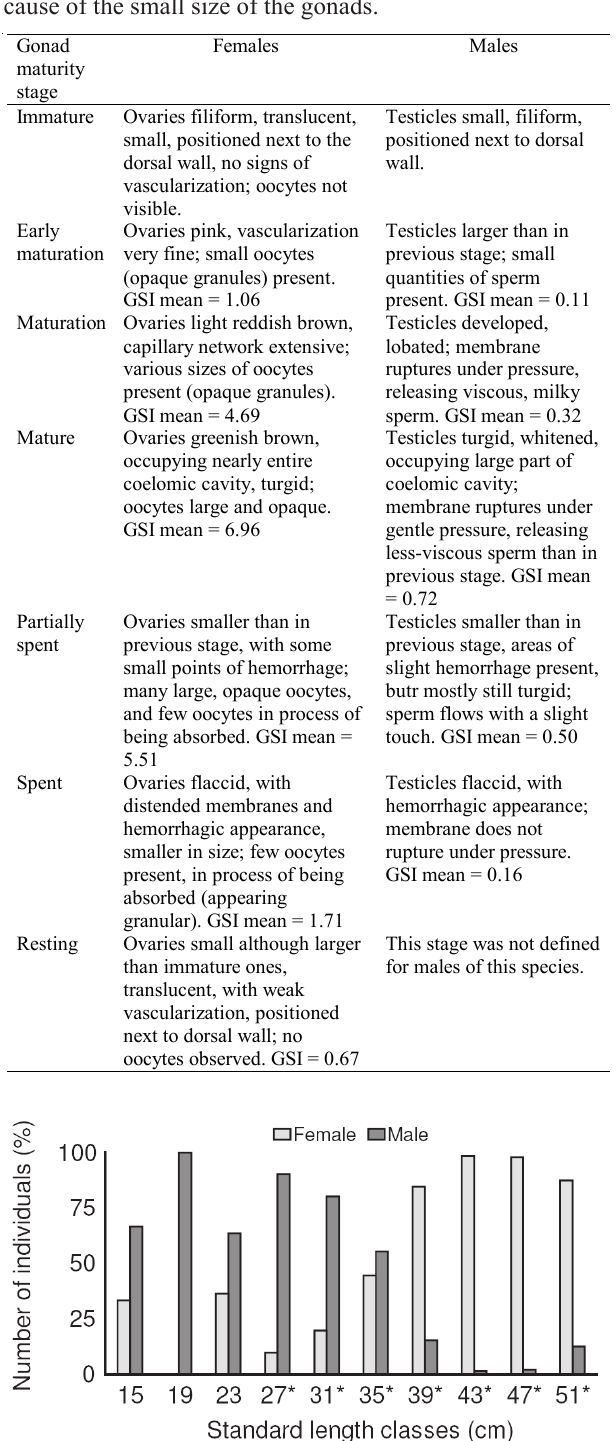
Table 1 . Macroscopic gonadal characterization of female and male Rhaphiodon vulpinus in different stages of gonadal maturity and mean gonadosomatic index values (GSI). The values of GSI for immature stages were not calculated be- cause of the small size of the gonads.